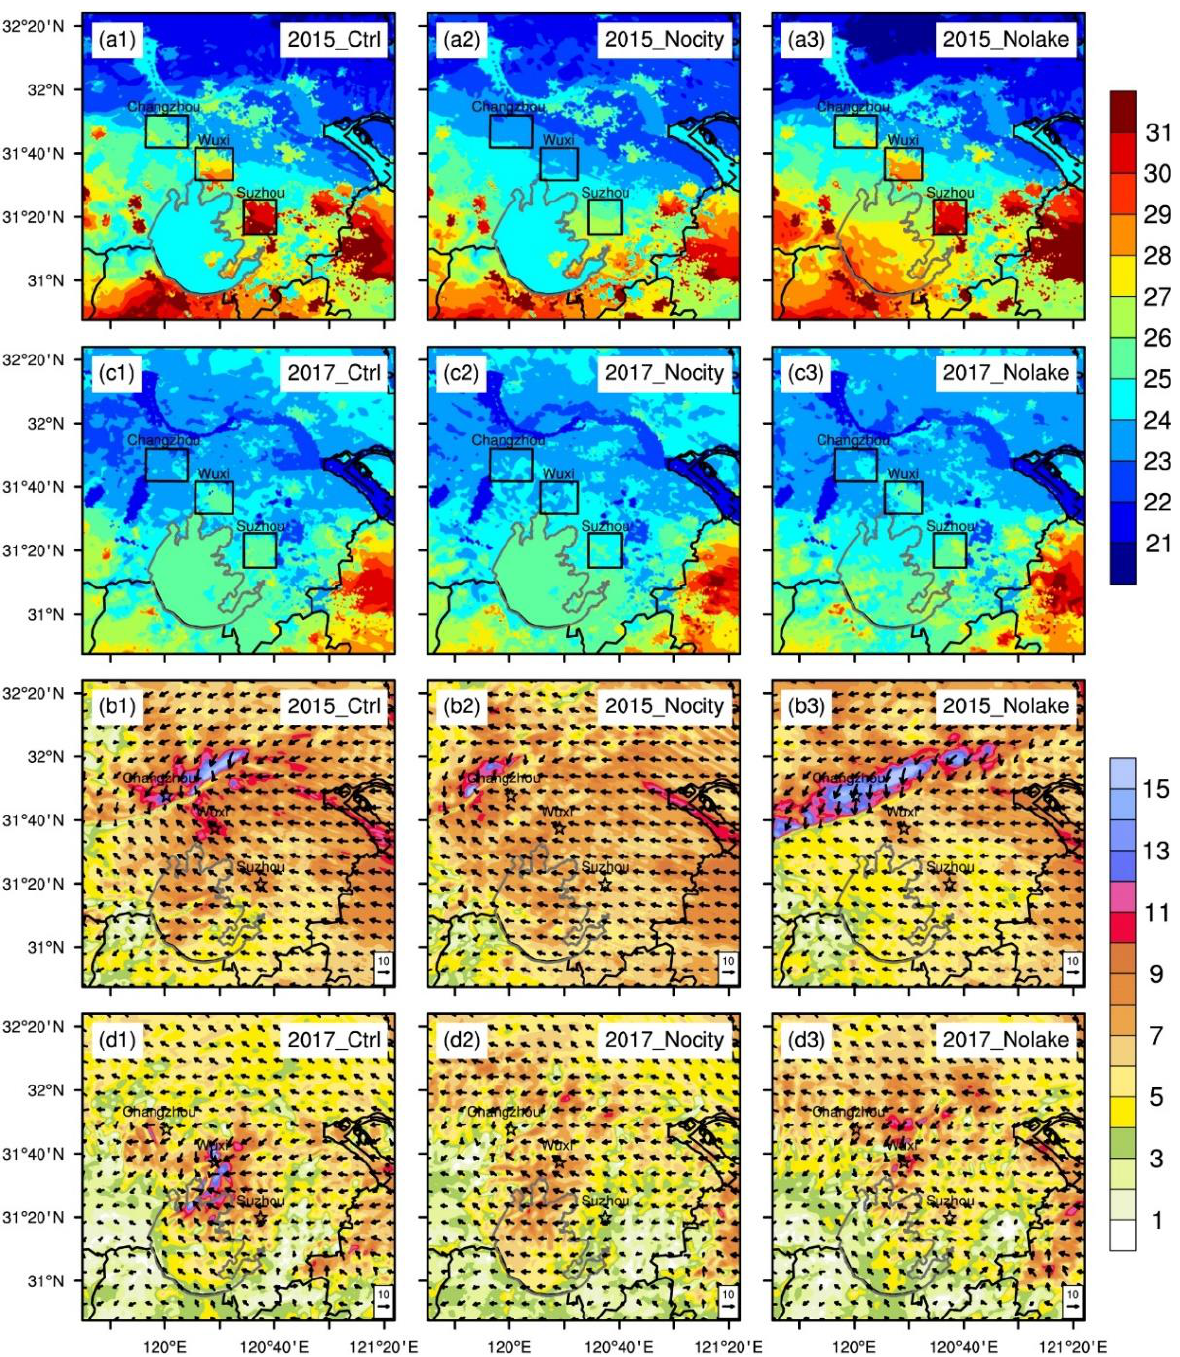
Figure 7. The spatial distributions of the simulated surface skin temperature (unit: °C) at one hour before the hour with the most intense precipitation, at ( a1 – a3 ) 14:00 in EP627 and at ( c1 – c3 ) 12:00 in EP925. ( b1 – b3 ) and ( d1 – d3 ) are the near-surface wind speed (unit: m s −1 ) and the wind direction (the arrows) at the starting point of the hour with the most intense precipitation, at 15:00 in EP627 and at 13:00 in EP925. 1–3 denote the control and two sensitive (Nocity and Nolake) runs, respectively. As the LLSL approaches the study area at 15:00, the near-surface wind forms evident high wind speed zones in Changzhou and Wuxi (Figure 7b1), and the high-speed center near Changzhou is as large as 15 m s −1 . At the same time, the surface convergence line (SCL) corresponding to the LLSL is generated near Changzhou (Figure 8a1) with an in- tensity of about −4 × 10 −3 s −1 . For Nocity, the area of near-surface high wind speed and the SCL are formed in the northwest, outside Changzhou (Figures 7b2 and 8a2), and the range and intensity are distinctly weaker than the control run. Although the near-surface wind speed is higher in Nolake than in the control run in Changzhou (Figure 7b3), the wind